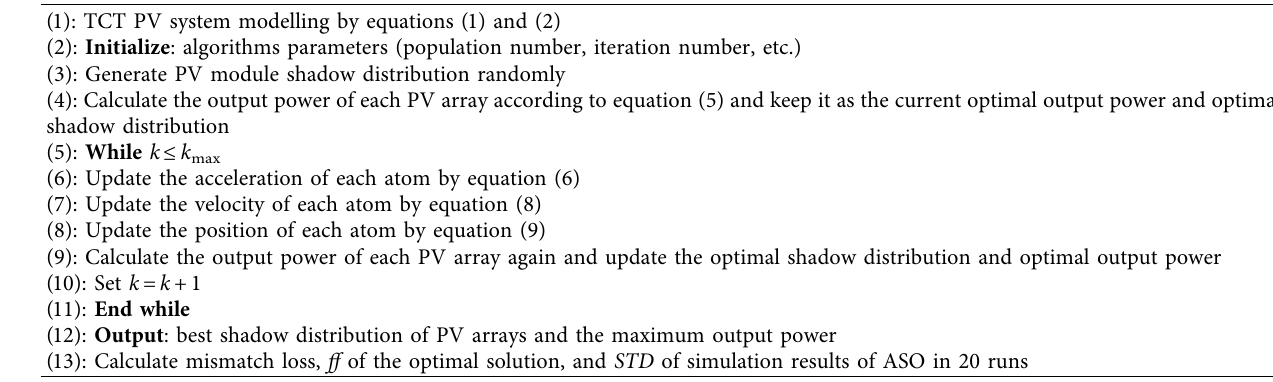
Table 1: Te detailed pseudocode of the ASO-based PV reconfguration method.